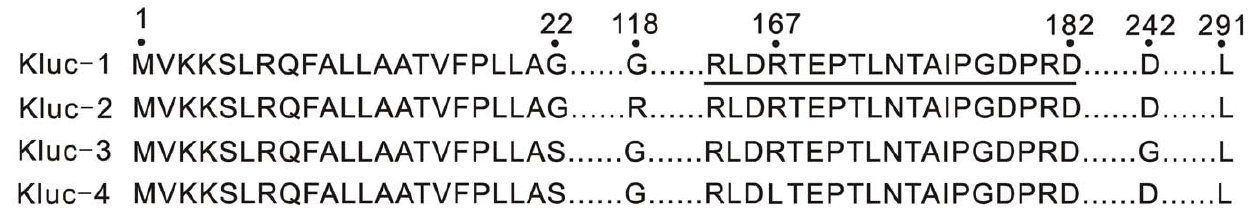
Figure 1. Amino acid sequence alignment of Kluc-3 and Kluc-4 with Kluc-1 from K.cryocrescens (GenBank accession No. AAK08976) and Kluc-2 from E.Cloacae (GenBank accession No. ABM73648). Dashes represent identical amino acid residues. The amino acids comprising the omega loop are underlined.